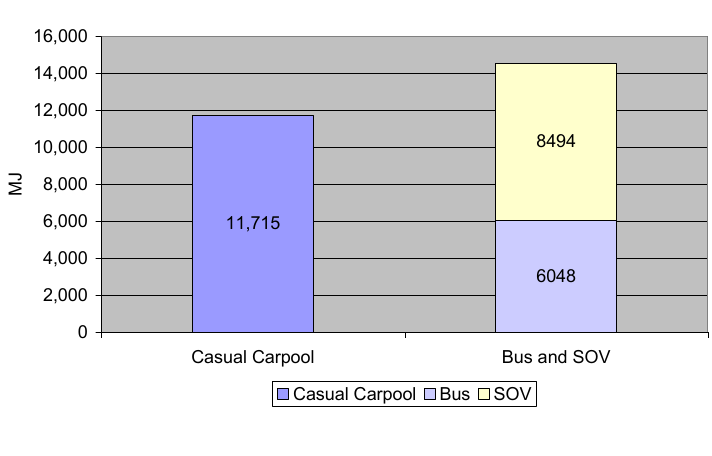
Figure 5. Comparative Energy Consumption of Travel for 600